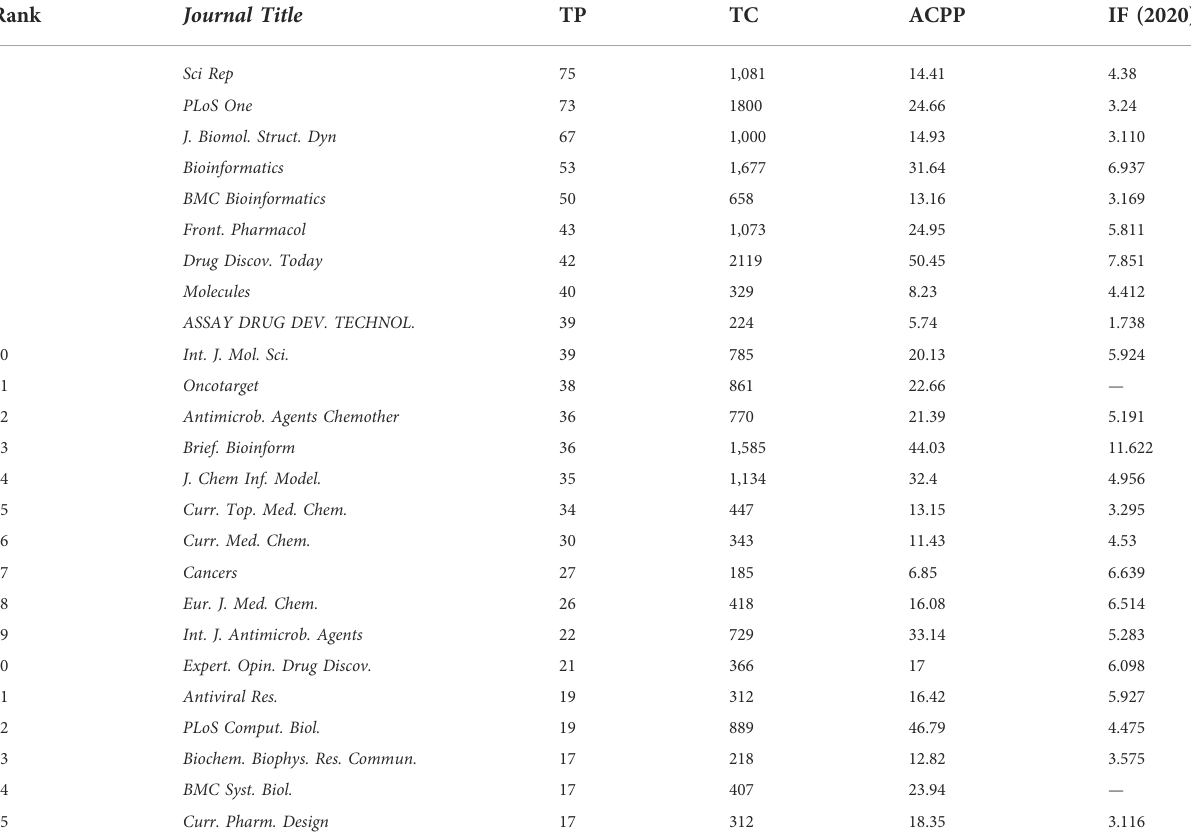
TABLE 4 Top 25 journals publishing studies in drug repositioning